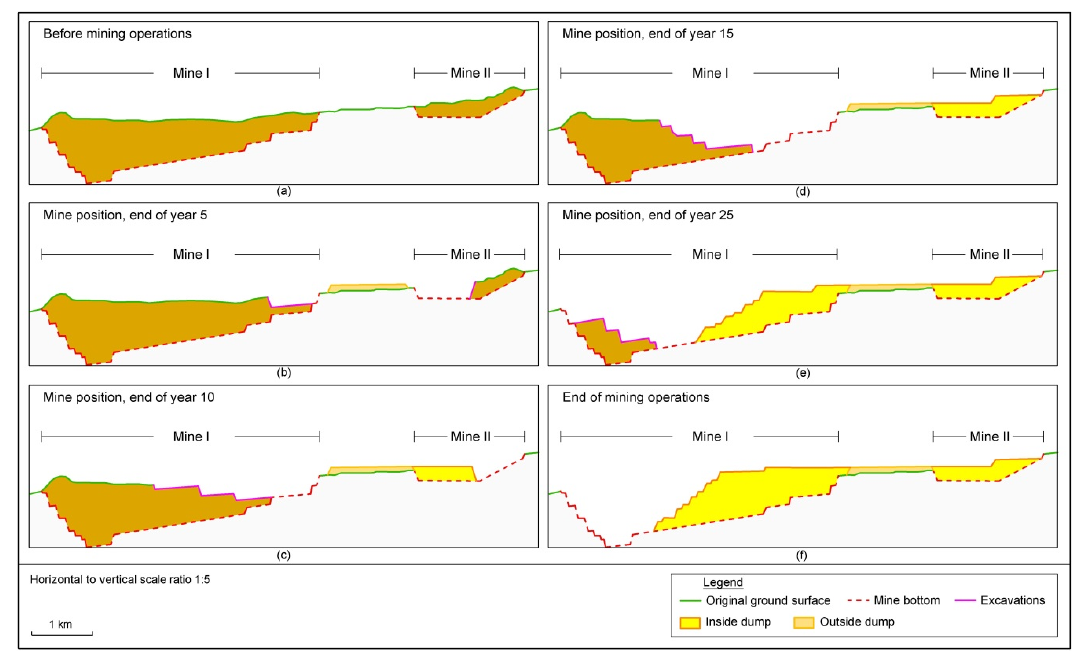
Figure 4. Sequence of mine development in the cross section A-A’ of Figure 2.